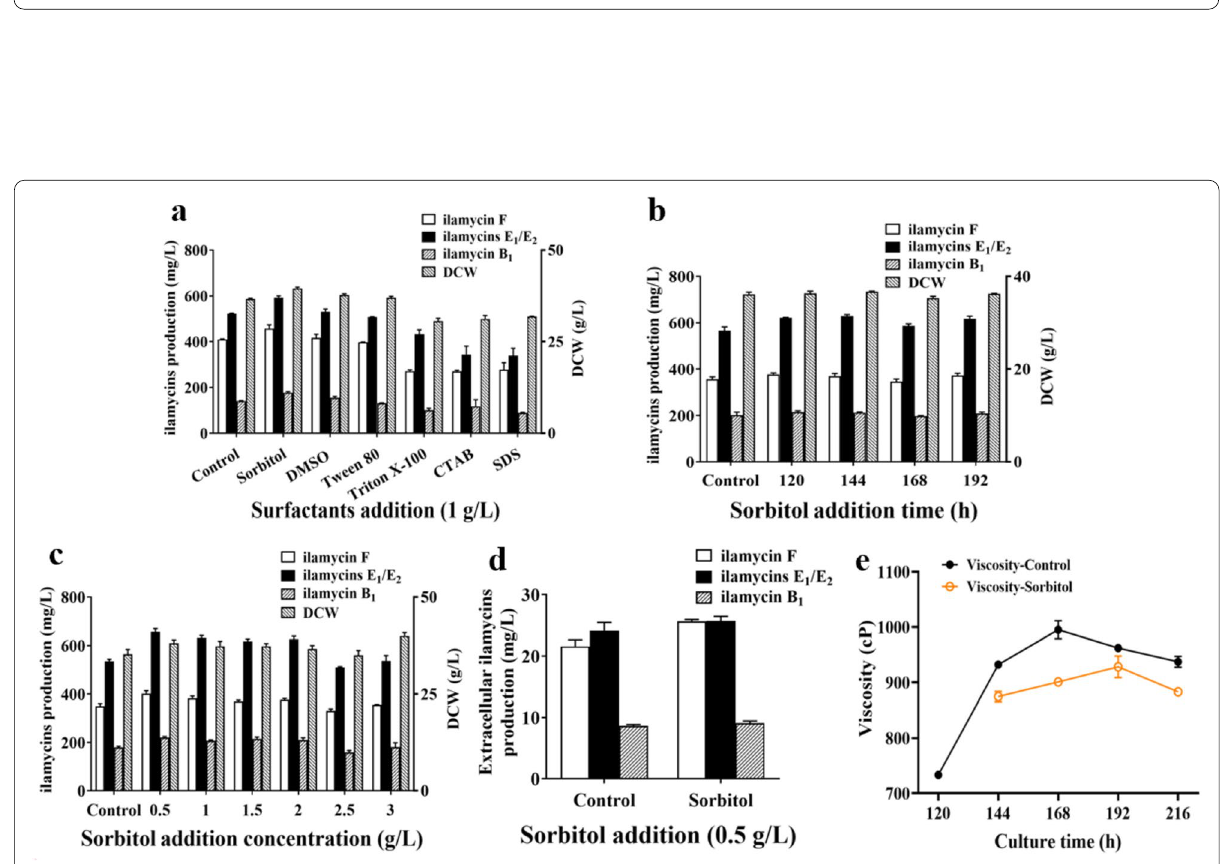
Fig. 7 The metabolic pathway of ilamycins synthesis precursors ( a ) and comparison between the transcriptional levels of target genes after ZnCl 2 ( b , c ), shikimic acid ( d ), Tyr ( e ) addition